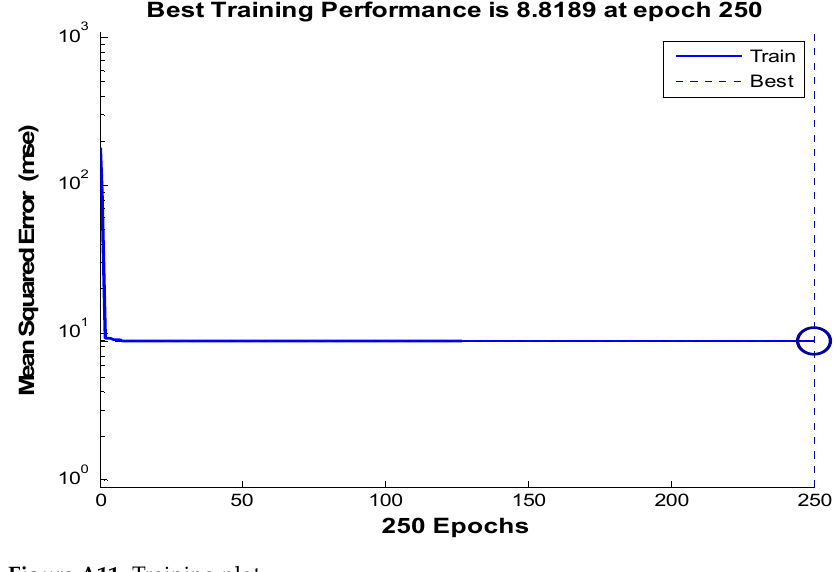
Figure A11. Training plot.